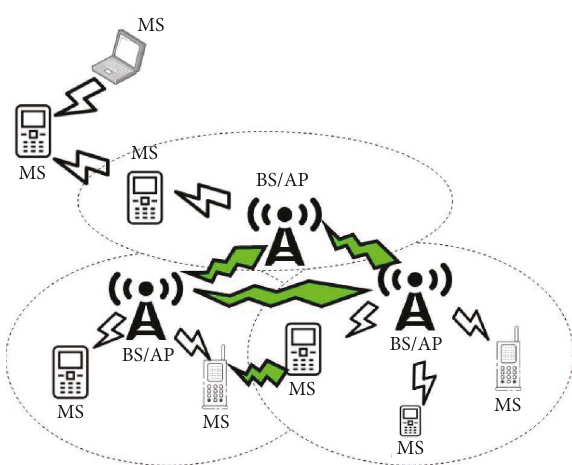
Figure 8: Mesh model.